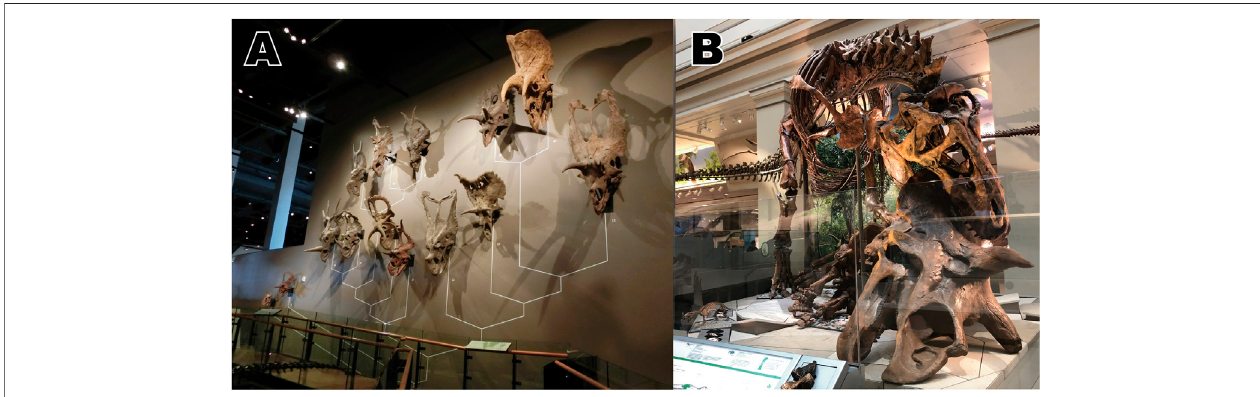
FIGURE 1 | Museum exhibitions using replica fossils. (A) An exhibition of the phylogenetic relationships of ceratopsian dinosaurs using skull replicas at the Natural History Museum of Utah, United States; (B) The nation ’ s T. rex ( Tyrannosaurus rex specimen, USNM PAL 555000) decapitating a Triceratops horridus (USNM PAL 500000) at the David H. Koch Hall of Fossils — Deep Time, at National Museum of Natural History, Smithsonian Institution, United States.